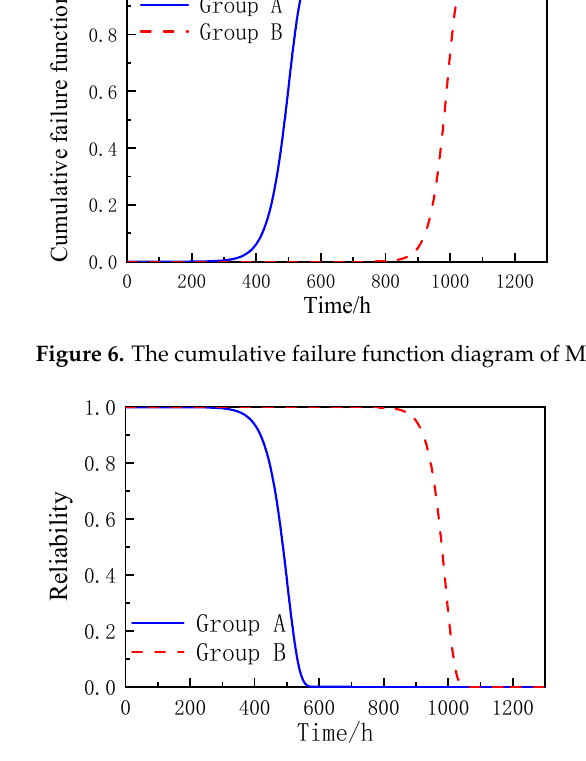
Figure 8. The probability density function of MOCRC. According to Figures 6–8, the Gumbel distribution pro fi le of MOCRC specimens un- der the accelerated corrosion action of electri fi cation varies with the thickness of the pro- tective layer of concrete reinforcement, and the thickness of the protective layer of rein- forcement has a great impact on the accelerated life of the specimens. As can be seen from the reliability function curve, the reliability of the accelerated corrosion life of the speci- men decreases with the prolonging of the constant current electri fi cation time. Among them, the Group A specimen has a large change after 300 h of accelerated corrosion, and it can be judged as a complete failure after 560 h. After 800 h of accelerated corrosion, the variation range of the Group B specimen is large, and it can be judged as a complete failure after 1050 h. In order to be tt er assess the Gumbel extremum distribution on Group A and B spec- imens’ accelerated life prediction, in combination with Minitab17.1 statistical analysis software to analyze the distribution pro fi le, we calculated the failure times and con fi dence